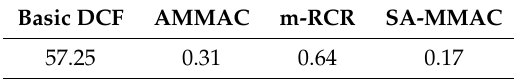
Table 4. Comparison of the FDR for 500 nodes, and 4